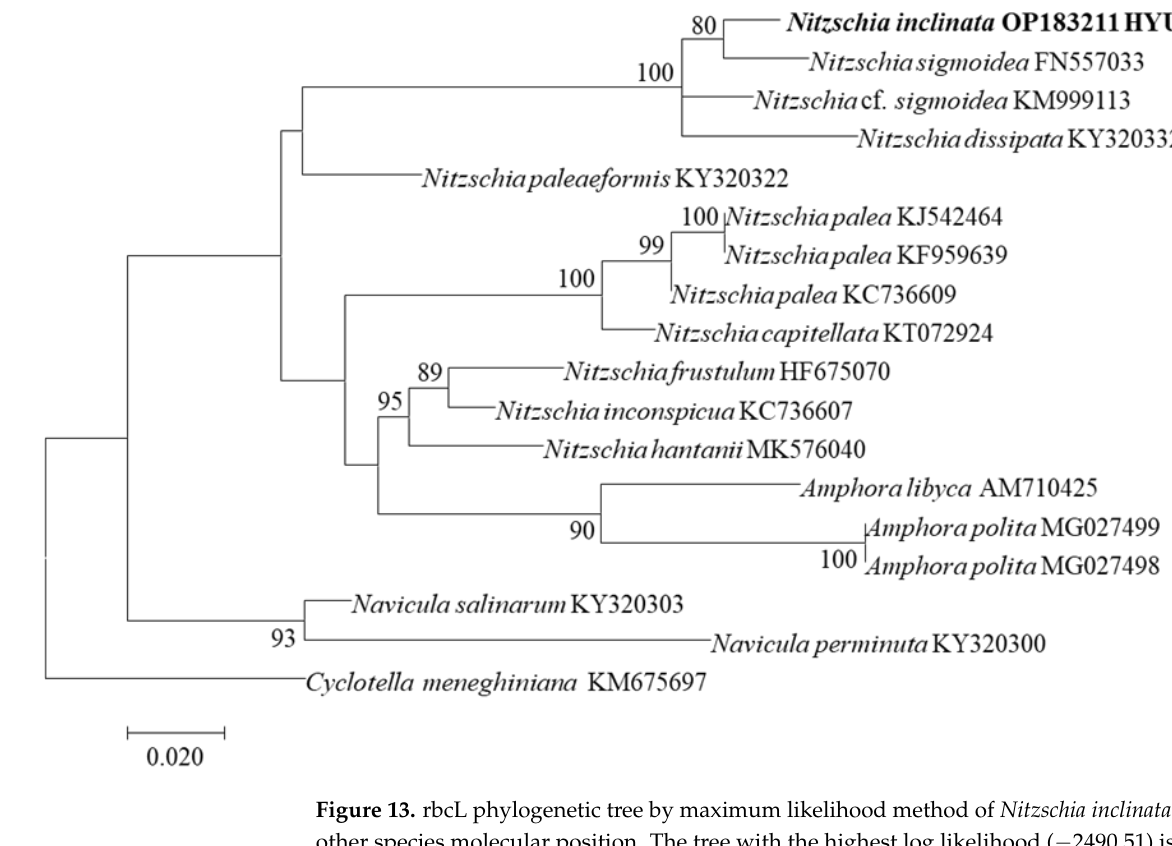
Figure 13. rbcL phylogenetic tree by maximum likelihood method of Nitzschia inclinata sp. nov. and other species molecular position. The tree with the highest log likelihood ( − 2490.51) is shown. The percentages of trees in which the associated taxa clustered together are shown next to the branches. The analysis involved 18 nucleotide sequences and 557 positions in the final data set. Cyclotella meneghiniana was used as the